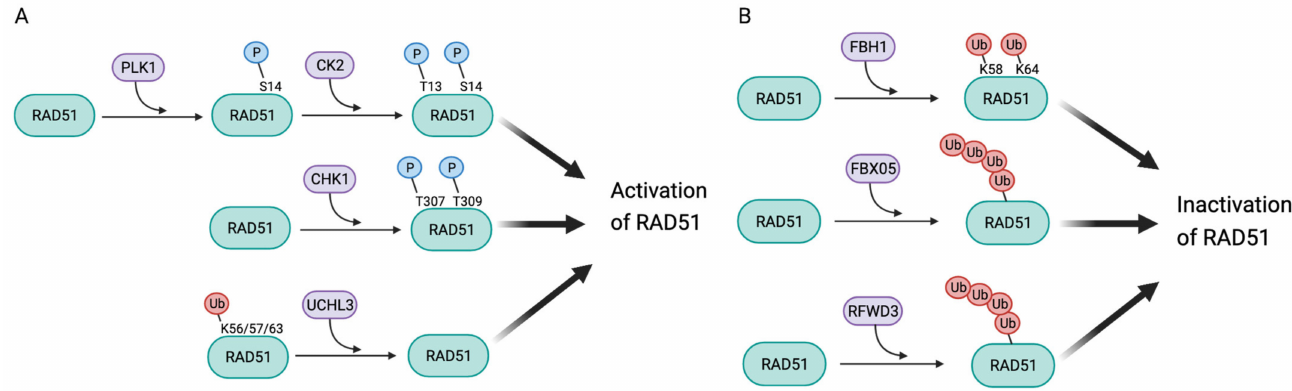
Figure 4. Post-translational modifications that impinge on RAD51 function. ( A ) Modifications leading to the activation and loading of RAD51: phosphorylation cascade at Ser14 and Thr13 by PLK1 and CK2, phosphorylation at Thr307/309 by CHK1, ubiquitination at Lys56/57/63 by UCHL3. ( B ) Modifications leading to the inactivation of RAD51: ubiquitination at Lys58/64 by FBH1, polyubiquitination by FBK05 or RFWD3 leading to the degradation of RAD51 by the proteasome. Blue bubbles (P) represent phosphorylation, red bubbles (Ub) represent